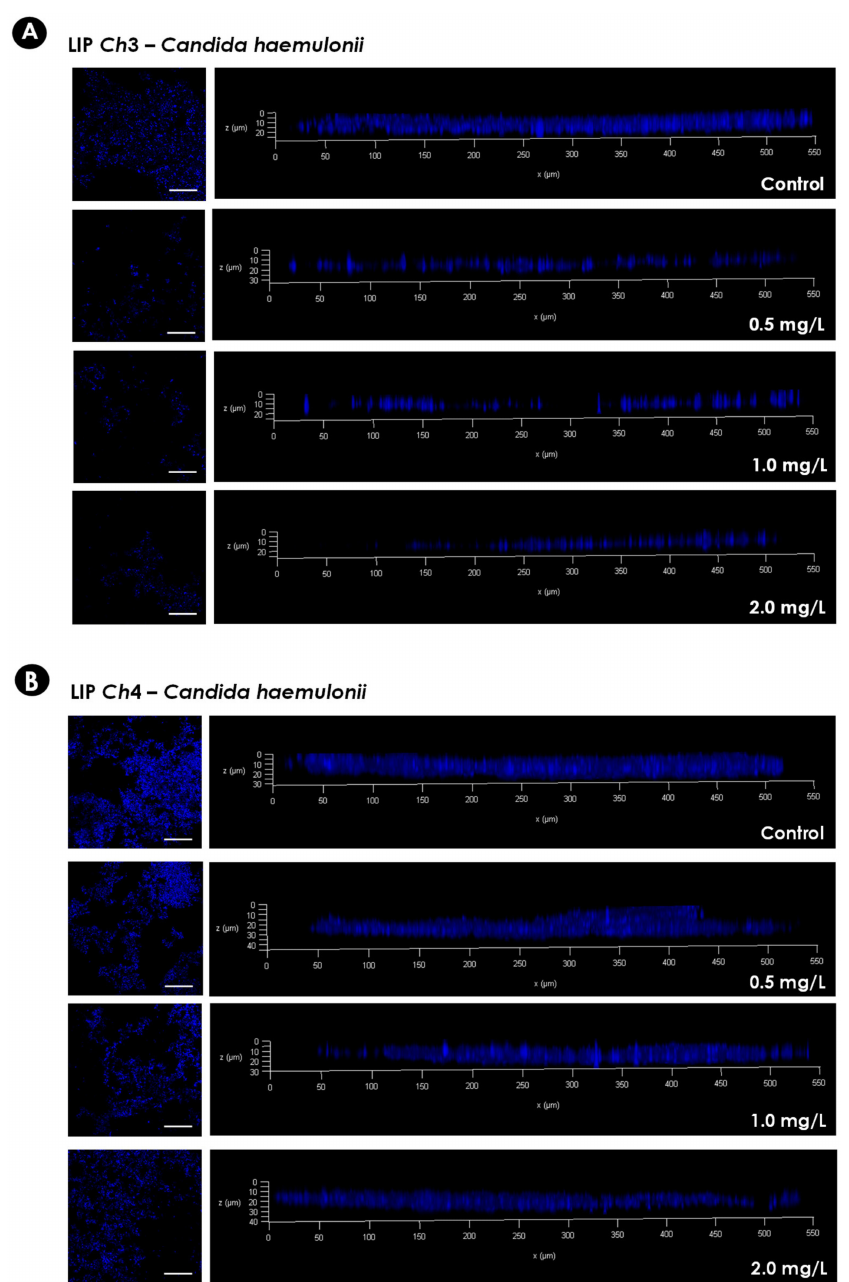
Figure 3. Representative confocal laser scanning microscopy (CLSM) images of the biofilms formed by C. haemulonii on a polystyrene surface. Yeasts (200 µ L containing 10 6 cells) were placed to interact with